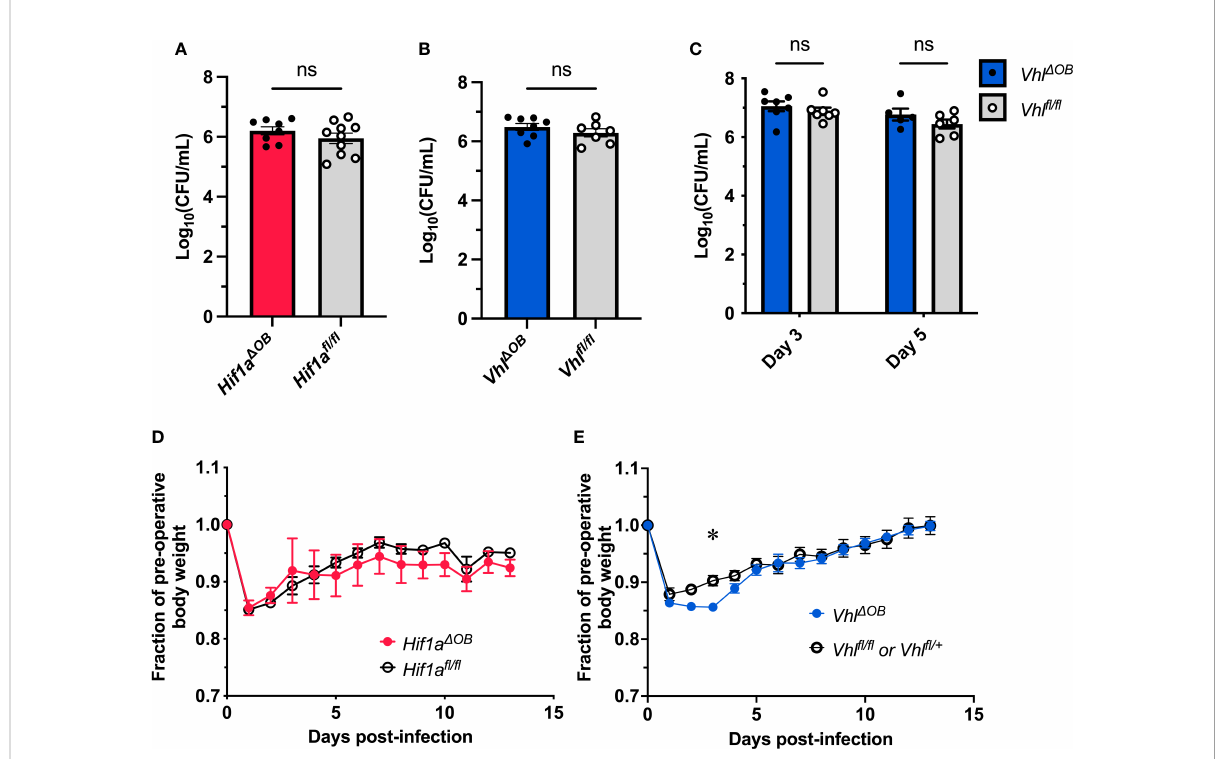
FIGURE 1 Conditional knockout of Hif1a or Vhl in the osteoblast lineage does not impact bacterial burdens. Bacterial burdens in infected femurs of female Hif1a D OB (A) and Vhl D OB (B) mice were measured at post-infection day 14 ( n =7-10, as shown). The bacterial burdens were compared to those of Cre-negative littermate controls that were homozygous for the respective fl oxed alleles. ns denotes not signi fi cant ( p >0.05) as determined by unpaired, two-tailed Student ’ s t -tests. (C) Bacterial burdens of Vhl D OB mice were measured at post-infection day 3 and day 5. The bacterial burdens of conditional knockout mice were compared to those of Vhl fl / fl littermate controls ( n =5-7 female mice as shown). The relative weights of the corresponding infected animals analyzed in (A, B) are shown in (D, E) , respectively. The weights were measured daily and normalized to the pre-operative, uninfected animal weights before comparison by two-way ANOVA with multiple comparisons. The weights of Hif1a D OB mice (D) were not found to signi fi cantly differ (not shown) from those of controls. Error bars represent mean±SEM. * p <0.05 as determined by two ‐ way analysis of variance (ANOVA) with multiple comparisons (C-E) . CFU, colony forming